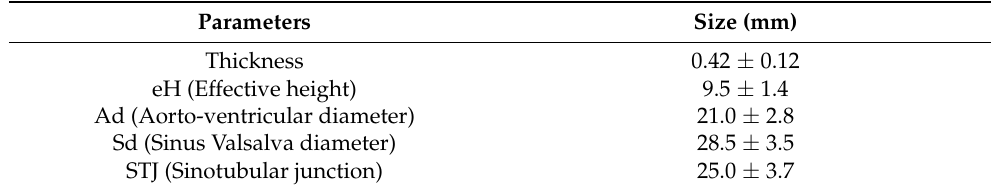
Table 1. Geometric parameters of aortic valves (mean ± std).